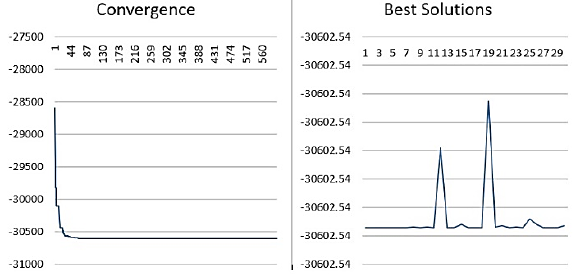
Figure 10. Convergence curve and 30 best solutions for constraint problem